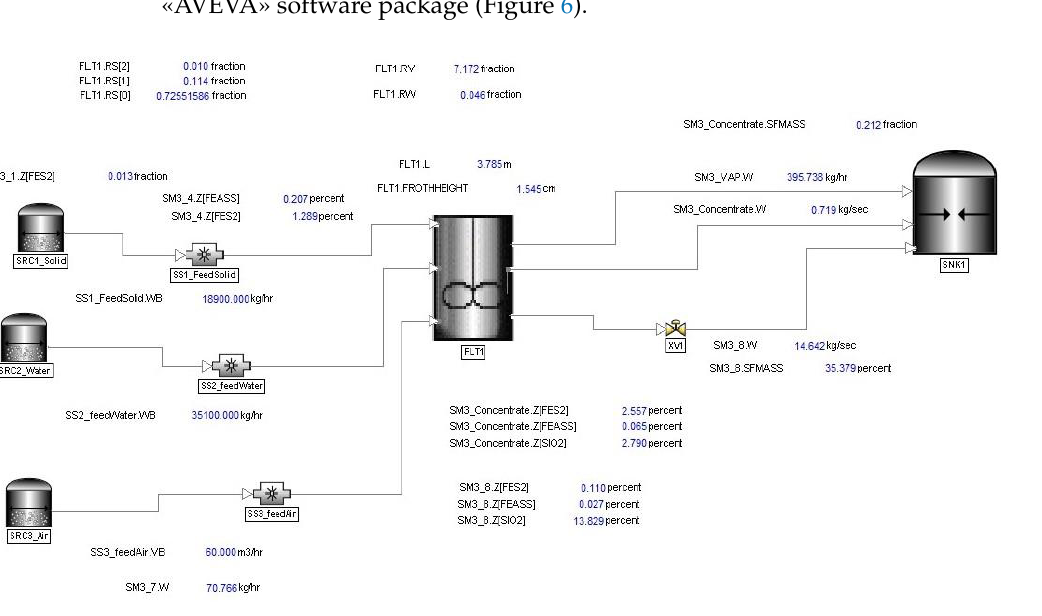
Figure 6. Flotation model.